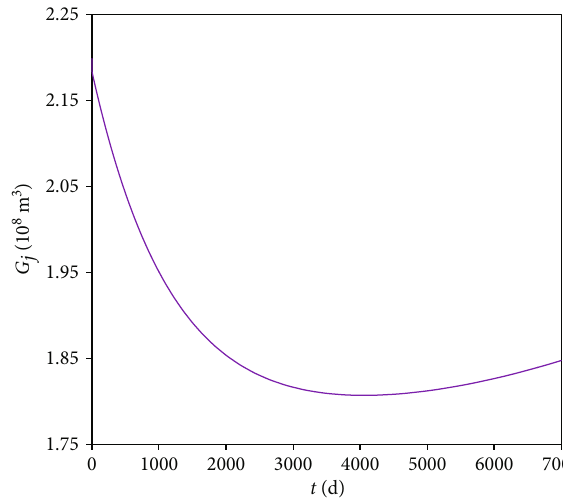
Figure 14: The estimated pro fi le of G